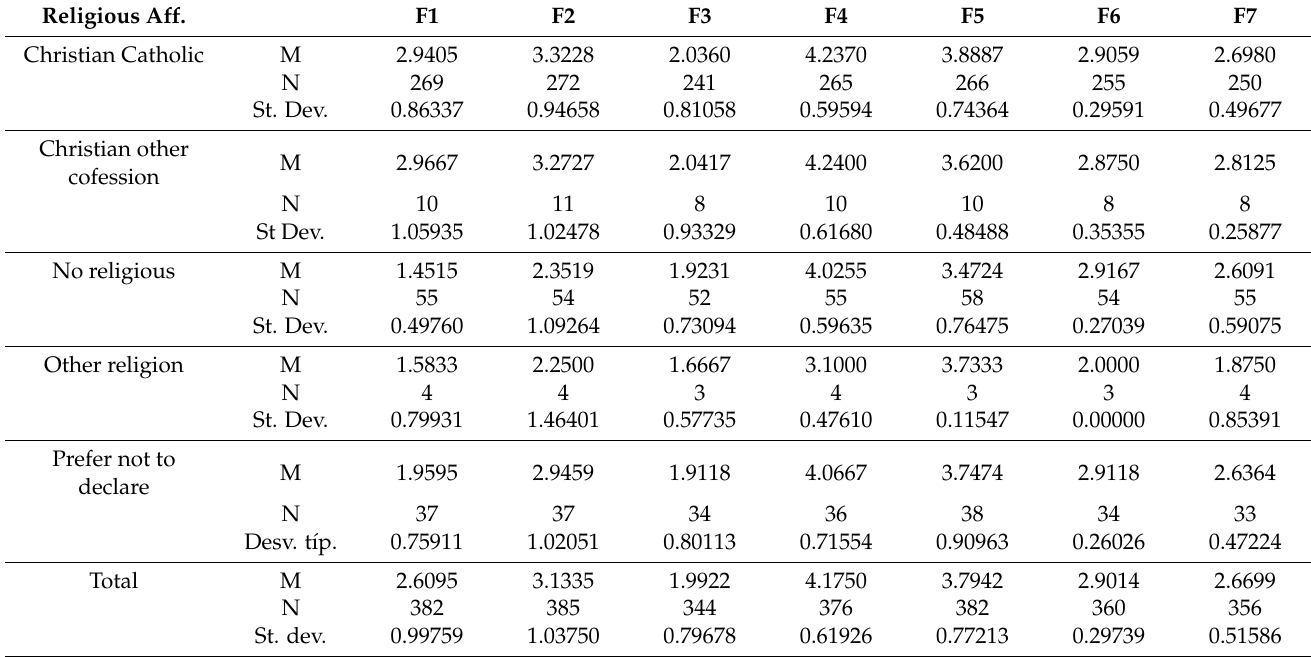
Table 3. Comparing means of factors by religious